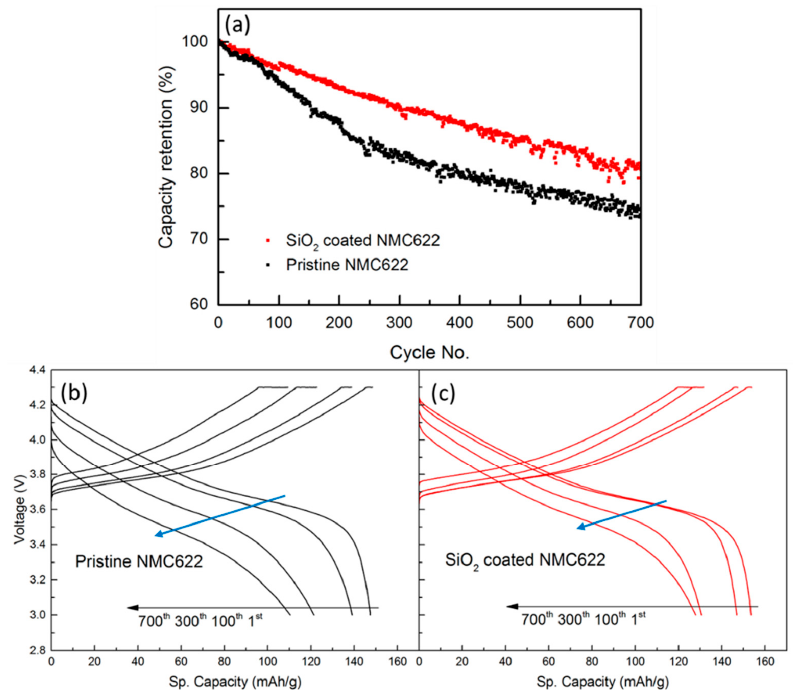
Figure 6. Cycling performance of electrode from pristine and SiO 2 -coated NMC622: ( a ) Capacity retention, and the charge–discharge curve of ( b ) pristine NMC622 and ( c ) SiO 2 -coated NMC622. The arrows show the discharge potential plateau decreasing.